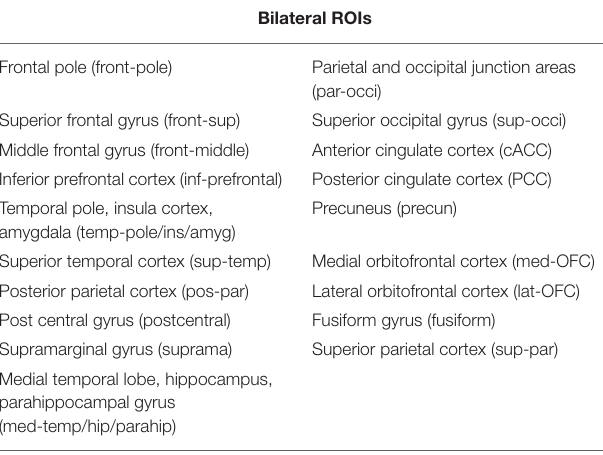
regions). Bilateral